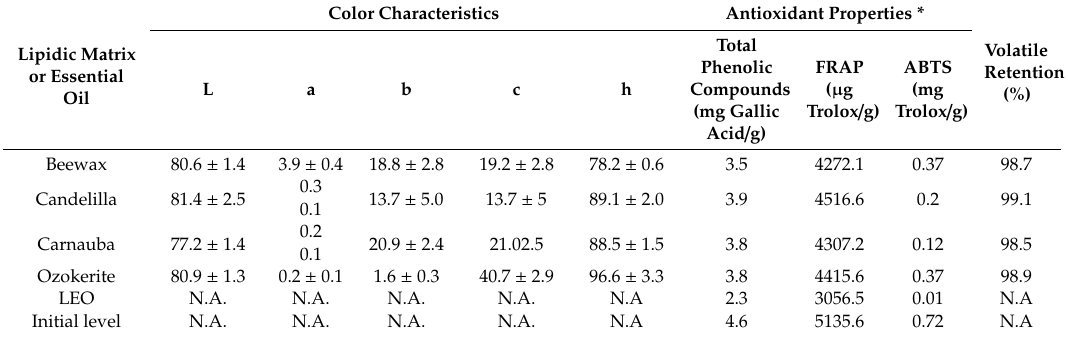
Table 5. Functional properties (color characteristics, volatile retention, and antioxidant activity) of lipidic